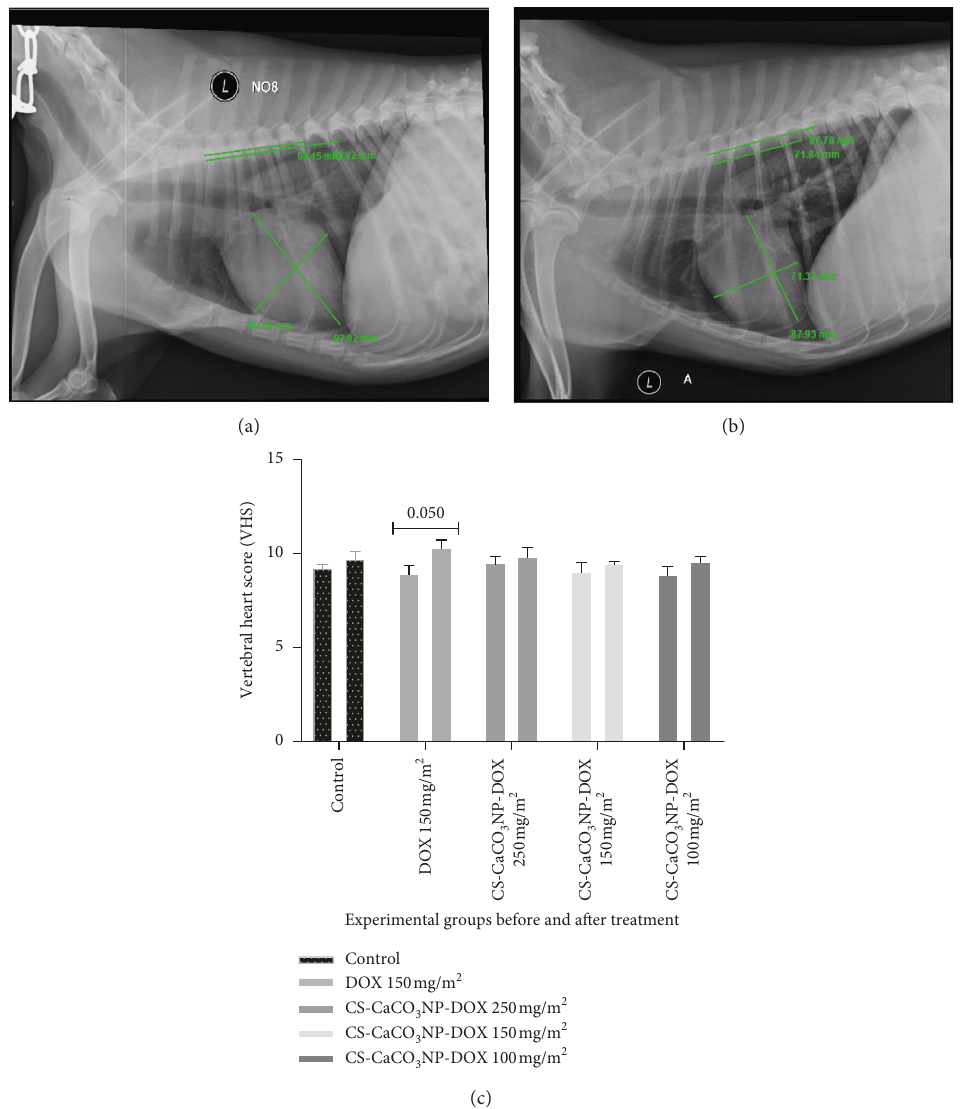
Figure 2: Thoracic radiographs and heart size score. (a) Initial and (b) final heart size measurement using vertebral heart score (VHS) index of dogs. (c) Mean vertebral heart score of dogs treated with free DOX and CS-CaCO 3 NP-DOX at different cumulative doses. All the data are expressed as mean SD, n (cid:31) ±